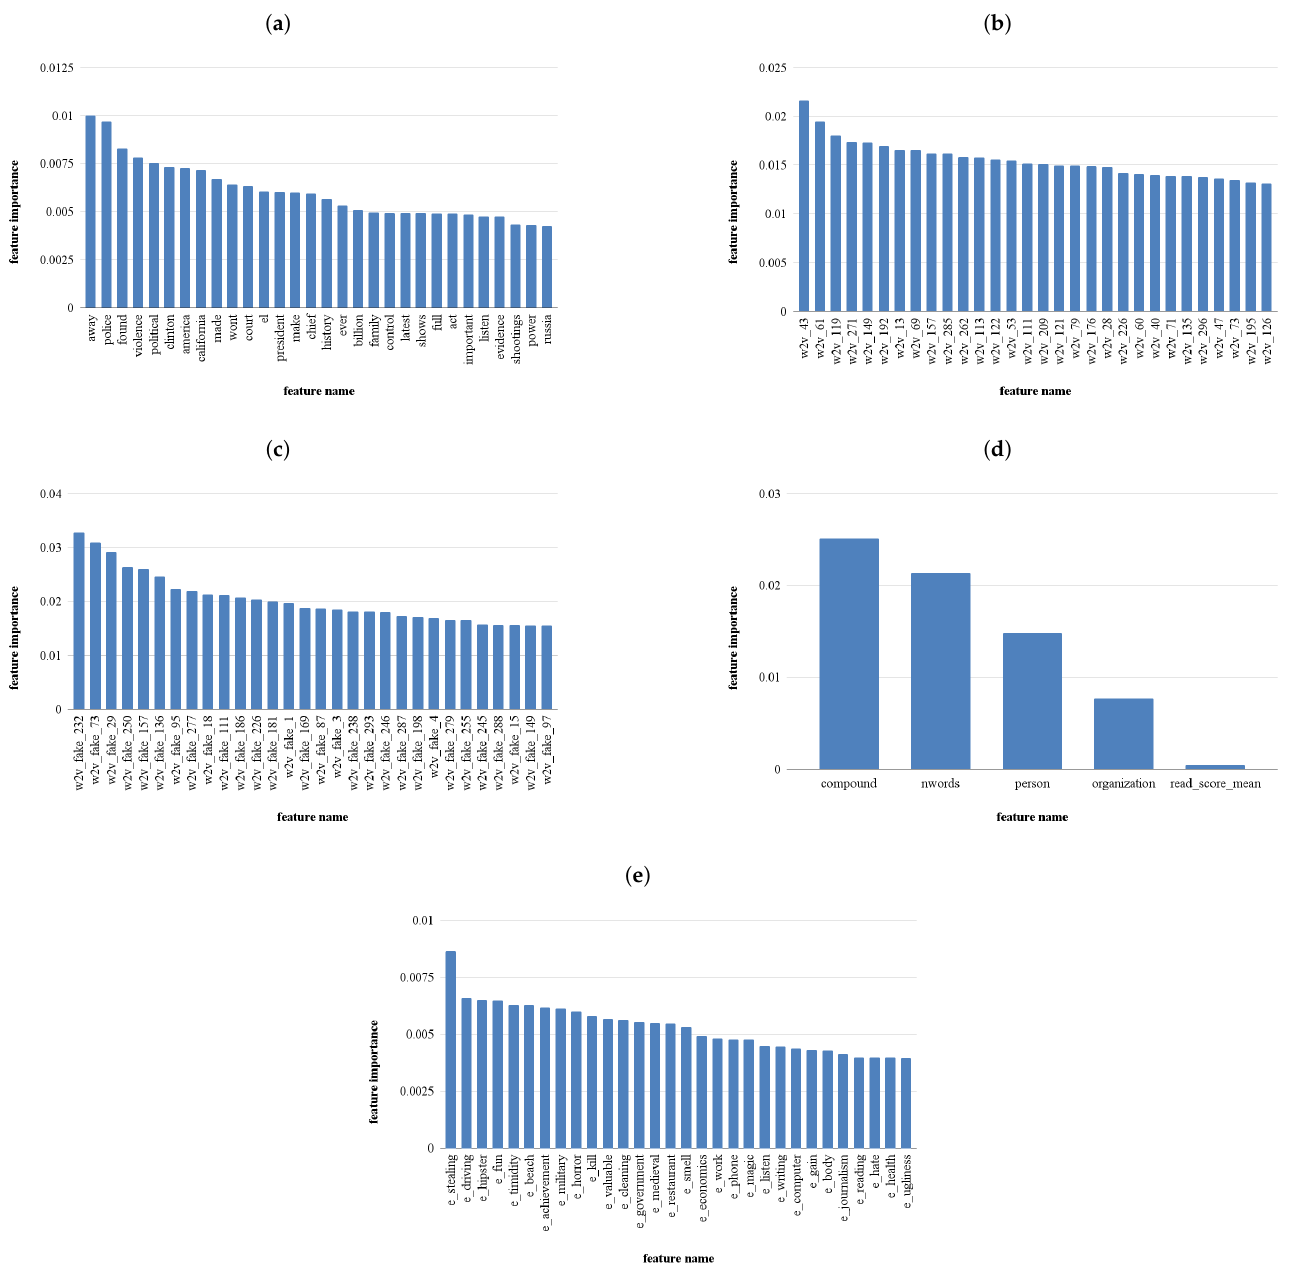
Figure A1. Importance of the 30 most relevant features from the different feature sets using a 30-day interval. In some scenarios, due to the pre-processing applied (removal of low variance and highly correlated features), the total number of features is inferior to